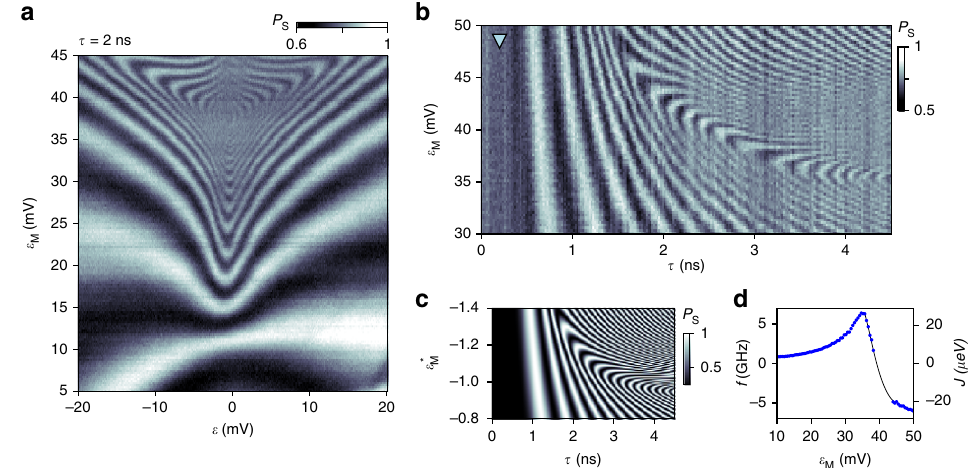
Fig. 4 Sweet-spot behavior and competition between direct and onsite processes. a P S ( ε , ε M ) for reduced interaction time τ = 2 ns. A fi ngerprint pattern, related to a sweet spot in the exchange pro fi le J ( ε , ε M ), emerges at the crossover from direct to onsite regimes. Measured ( b ) and simulated ( c ) time- dependent exchange oscillations for fi xed ε = 8 mV (marked by blue triangle in Fig. 3b). Enhanced oscillation visibility along the chevron pattern indicates that operation at the sweet spot prolongs coherence. d Coupling strength of the quantum mediator, demonstrating high speed (GHz), sweet spot (maximum), and sign reversal, controlled by small voltage changes in ε M . Data points represent the oscillation frequency extracted from rows in panel ( b ), which we identify with the exchange coupling strength J = hf . Solid line is a guide to the